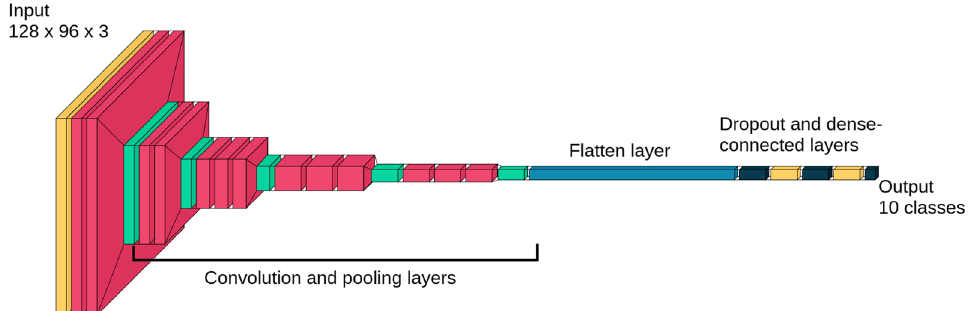
Figure 3. Graphical representation of the modified VGG16 model; the model takes a 128 × 96 color image as input (extreme left) and converts it to a 10 class output (extreme right); the dark blue block represents the flattened output of the convolution and max pooling layers of VGG16, which is followed by fully connected and dropout layers (Figure produced with the Visualkeras python library, version 0.0.2, https:// github. com/ paulg avrik ov/ visua